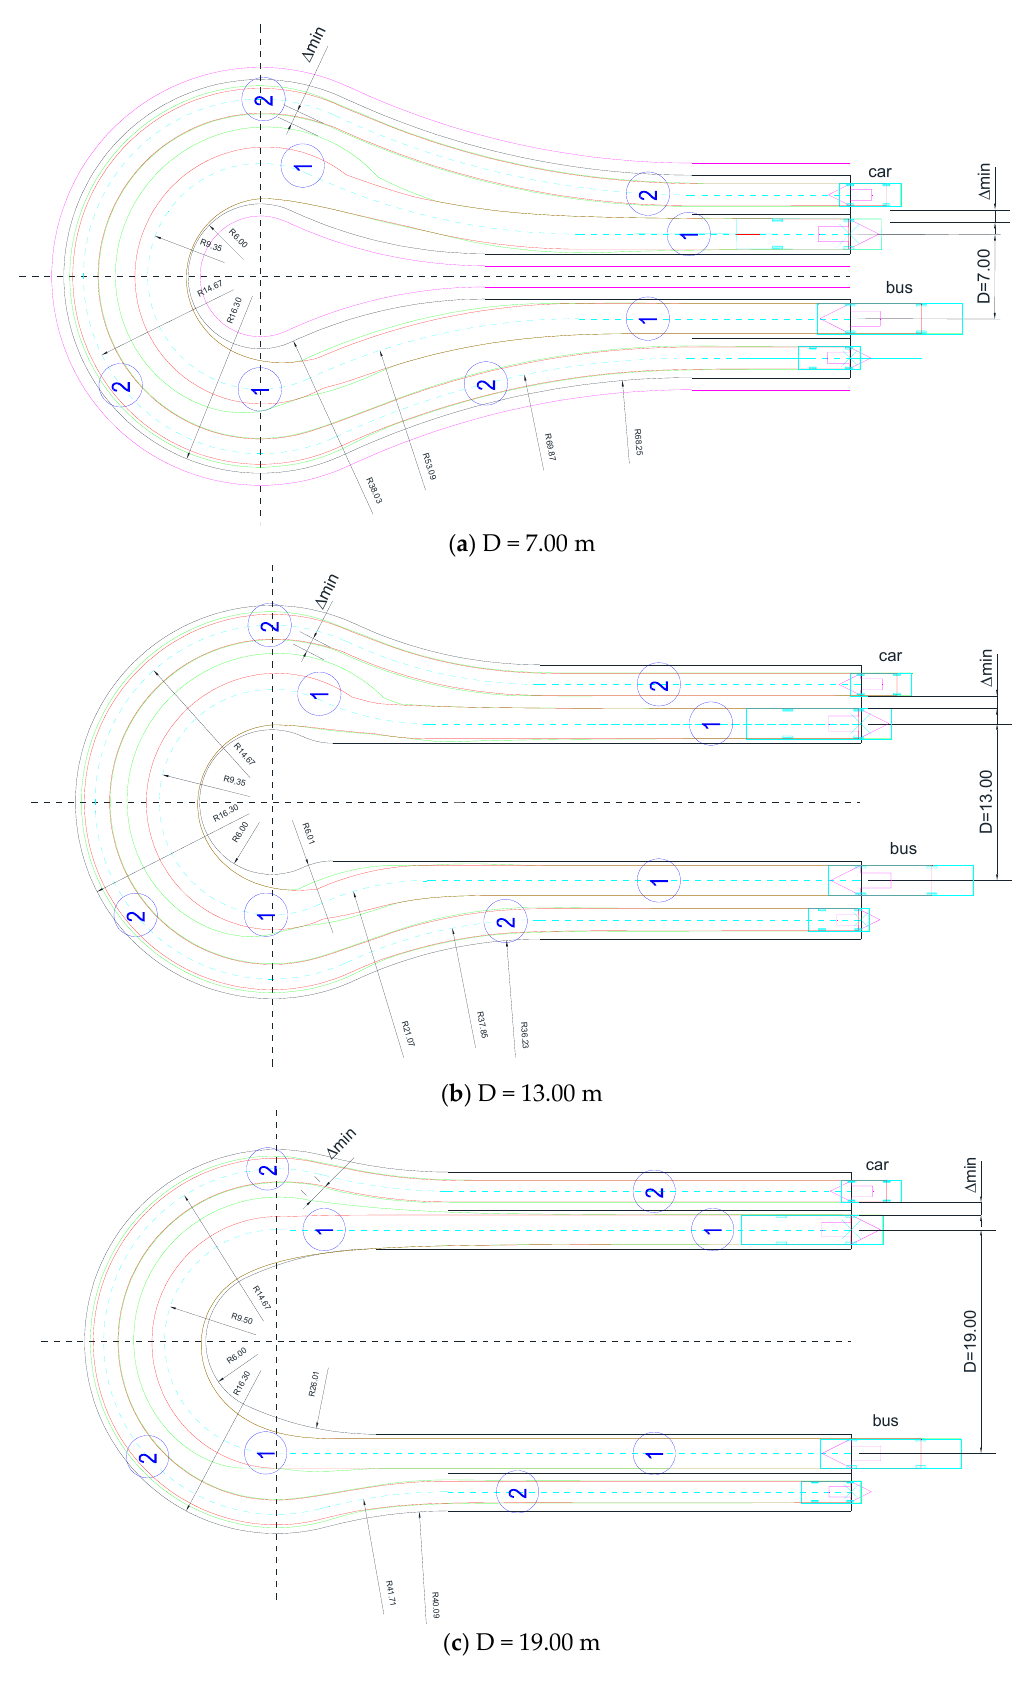
Figure 6. Italian hairpin bends geometrical layouts (12 m long bus–car crossing) on road F2